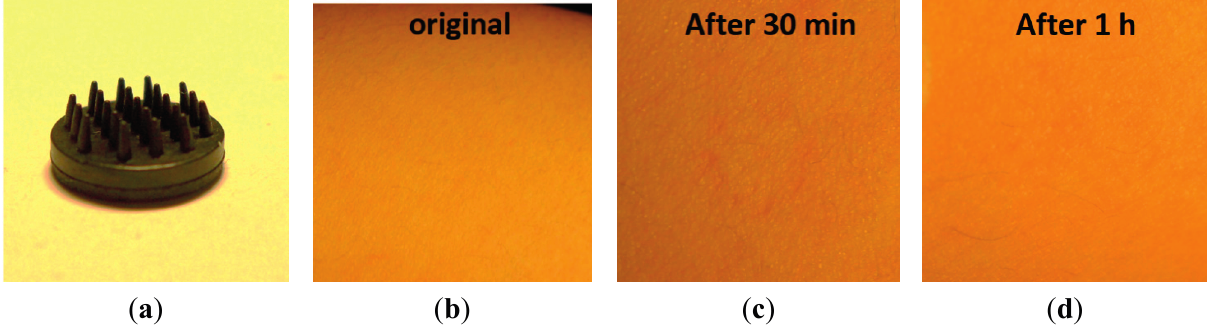
Figure 13. Skin irritation experiment for short term use of polymer electrodes ( a ) electrode with pins of 2 mm length; ( b ) Skin condition before and ( c , d ) after contact with short pin electrode.